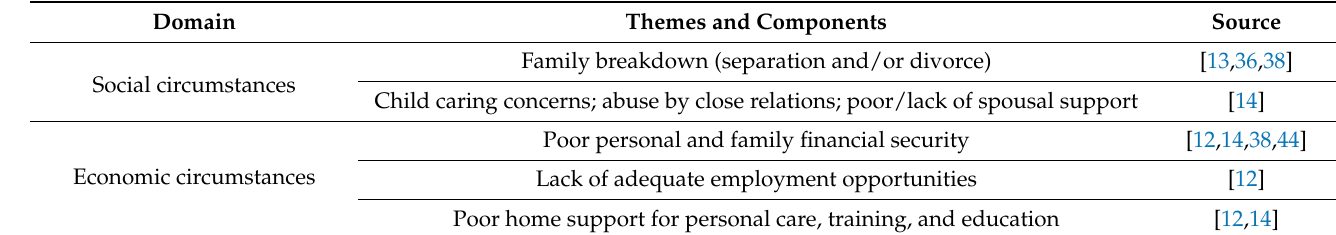
Table 3. Young construction workers’ socio-economic psychosocial risk factors.